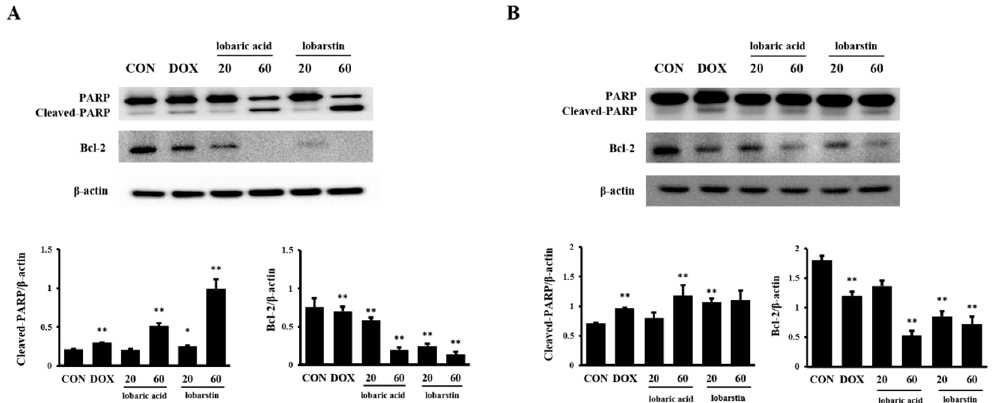
Figure 5. Effect of lobaric acid and lobarstin on the protein levels of cleaved PARP and Bcl-2 in HeLa and HCT116 cells. ( A ) HeLa and ( B ) HCT116 cells were treated with different concentrations of lobaric acid and lobarstin (20 or 60 μ M) for 24 h. The expression of the indicated proteins was investigated by western blot analysis; β -actin was used as loading control. The densitometry value of each band was determined with the Image J software. Data are presented as the mean ± SEM of duplicate independent experiments; * p < 0.05 compared with control; ** p < 0.01 compared with control.